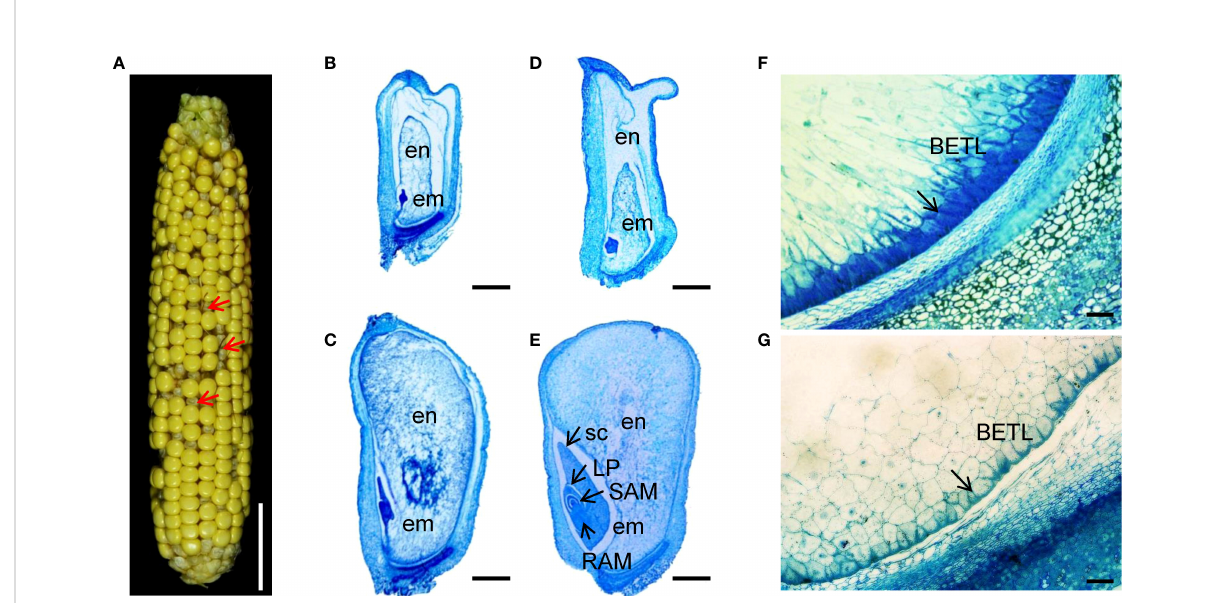
FIGURE 1 Embryo and endosperm development is arrested in the zmnmat1 mutant. (A) zmnmat1 mutant ears at 15 DAP. Red arrows indicate the empty pericarp kernels. Scale bar =4 cm. (B-E) Paraf fi n sections of 10 DAP (B, C) and 15 DAP (D, E) WT (C, E) and mutant (B, D) kernels from F 2 ears crossed by zmnmat1 and B73. Arrows indicate the embryo. em, embryo; en, endosperm; LP, leaf primordia; RAM, root apical meristem; SAM, shoot apical meristem; sc, scutellum. Scale bar =1 mm. (F, G) The BETL cells of 15 DAP WT (F) and zmnmat1 mutant kernel (G) . Arrows indicate the BETL cells. Scale bar=50 m